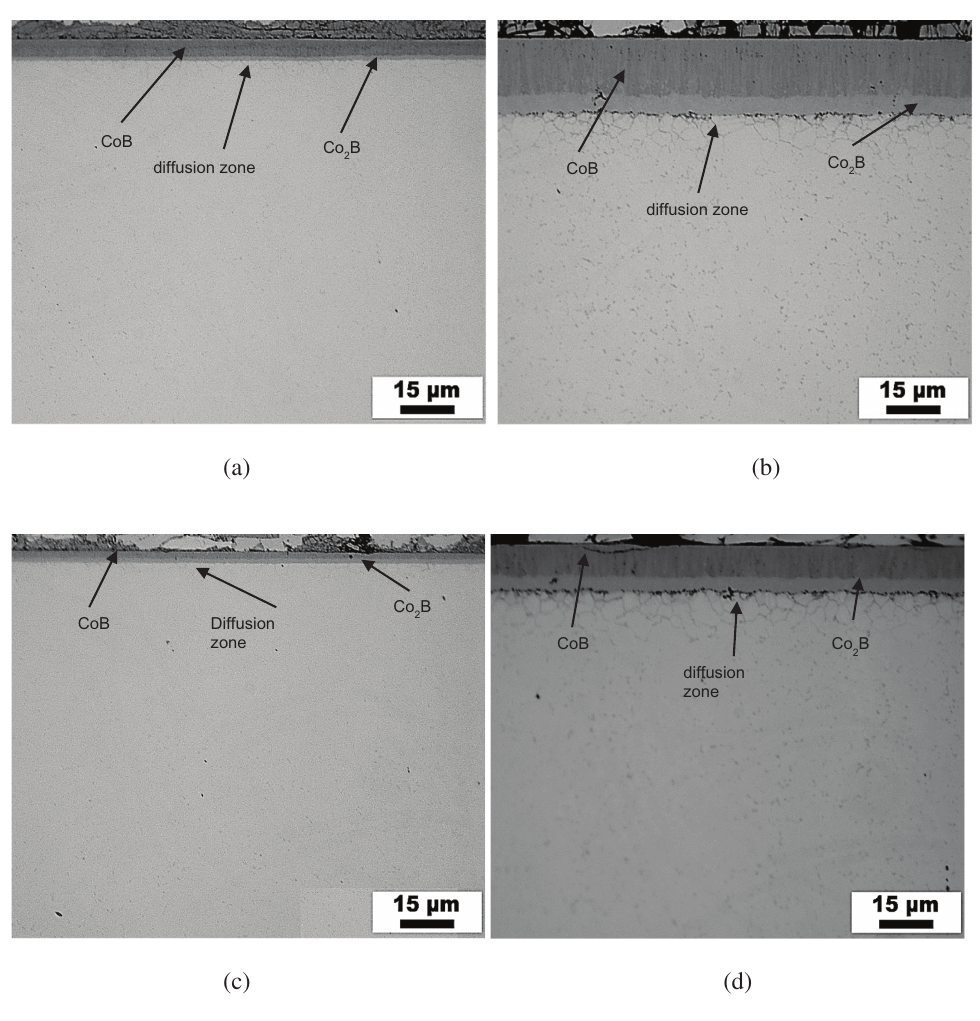
Figure 3: The CoB – Co 2 B layers obtained on the side facing the anode with boriding conditions of: (a) 1048 K with 0.5 h of exposure, (b) 1148 K with 2 h of exposure. The microstructure of cobalt boride layers developed on the surface exposed to the cathode at: (c) 1048 K with 0.5 h of exposure, (d) 1148 K with 2 h of